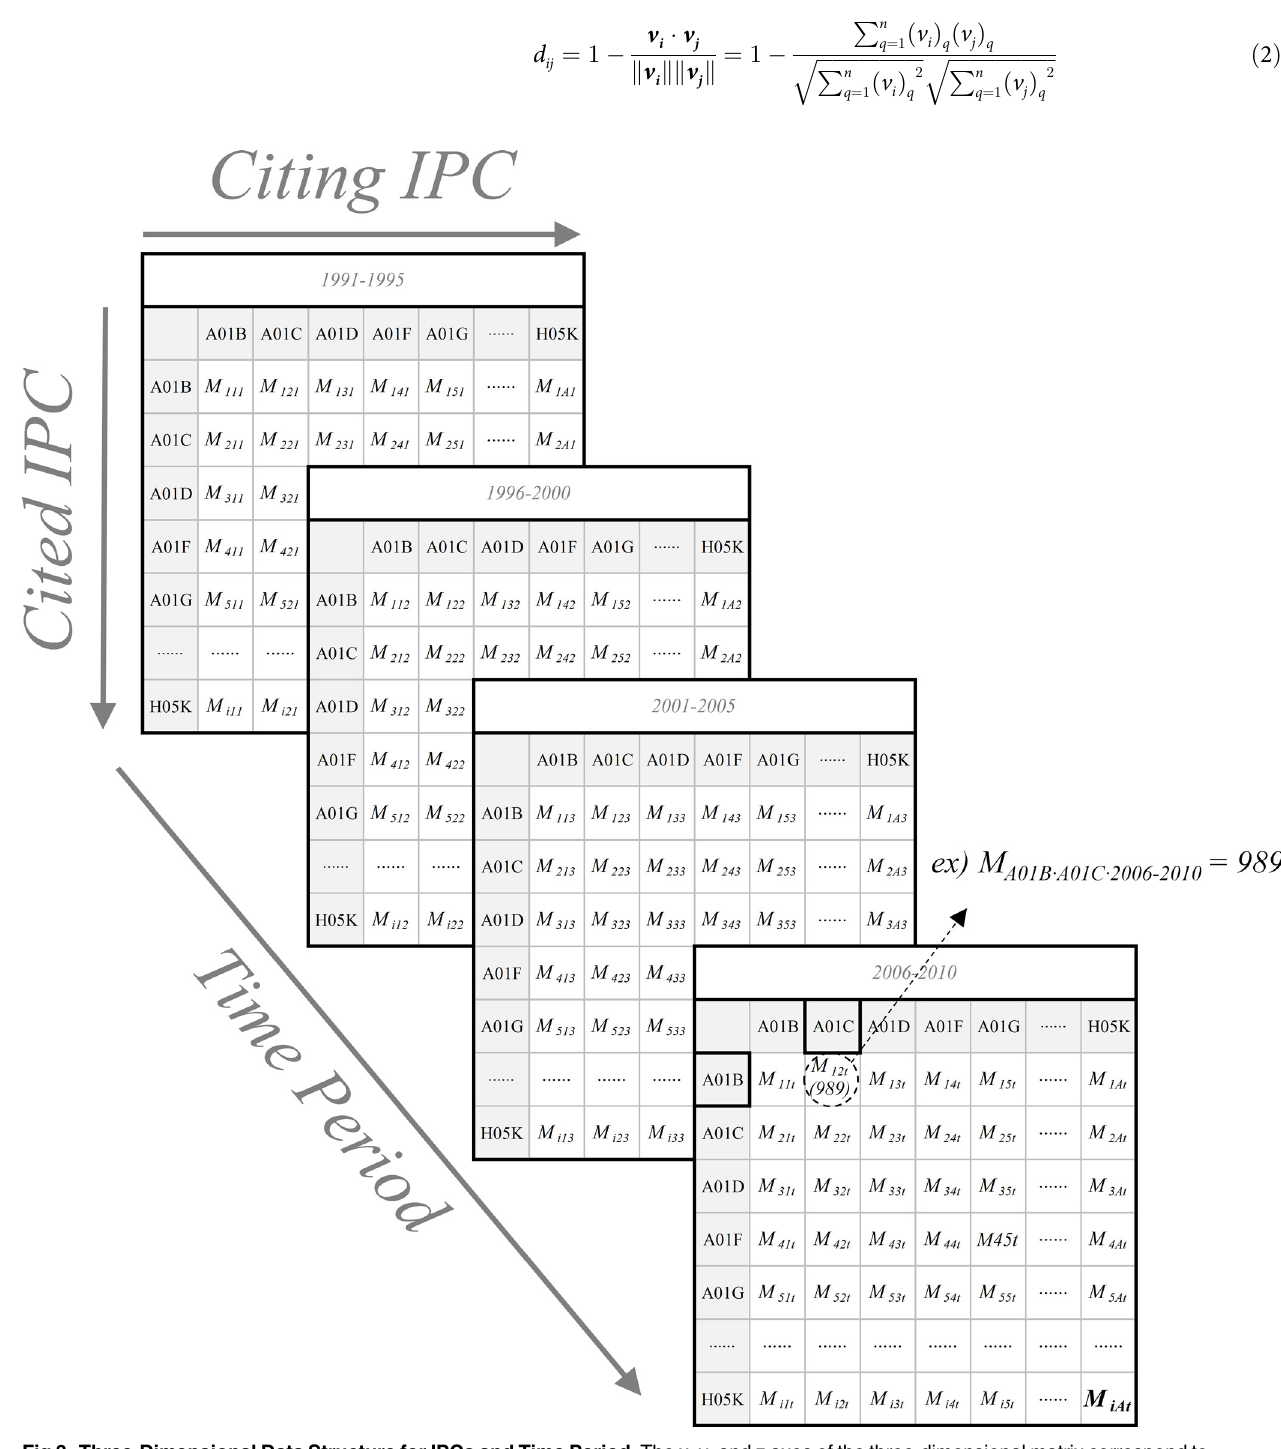
Fig 3. Three-Dimensional Data Structure for IPCs and Time Period. The x, y, and z axes of the three-dimensional matrix correspond to CitingIPC (Technology A ), CitedIPC (Technology i ), and Time Period ( t ), respectively. In each cell, M iAt is the frequency with which technology A cites technology i at period t . For instance, if A01C (IPC Subclass) cites A01B 989 times during the period 2006 − 2010, then M A01B (cid:2) A01C (cid:2) (2006 − 2010) becomes